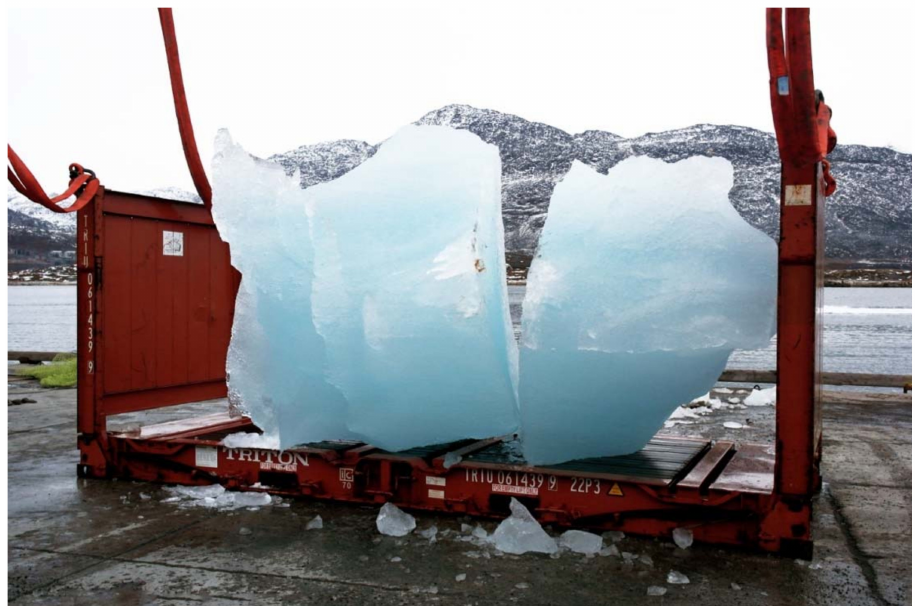
Figure 1. Loading ice at Nuuk Port and Harbour, Greenland, for Ice Watch in Copenhagen, 2014. Photo: Group Greenland. © 2014 Olafur Eliasson. Used by